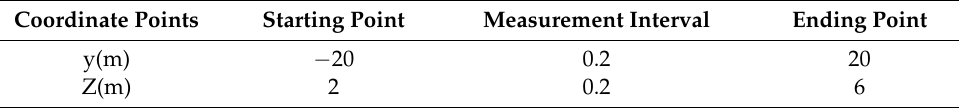
Figure 20. Field strength point scan range. Table 5. Data transmission line around electric field scanning